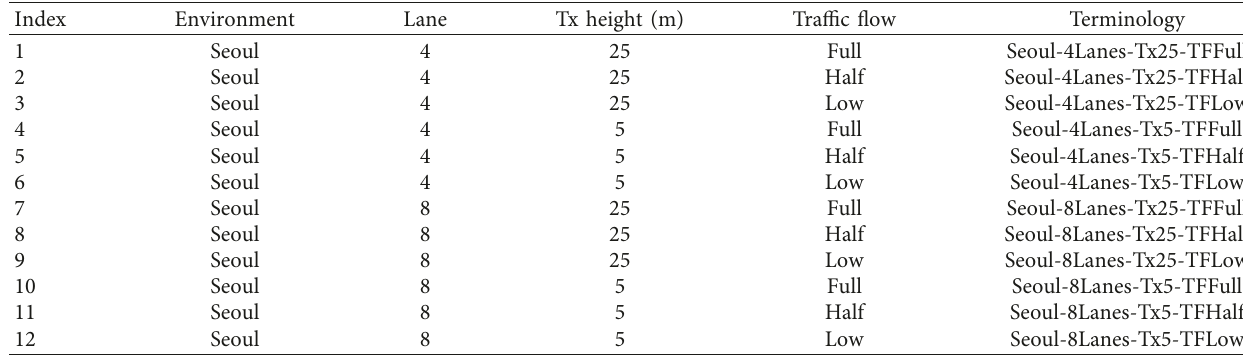
Table 5: Analysis cases.